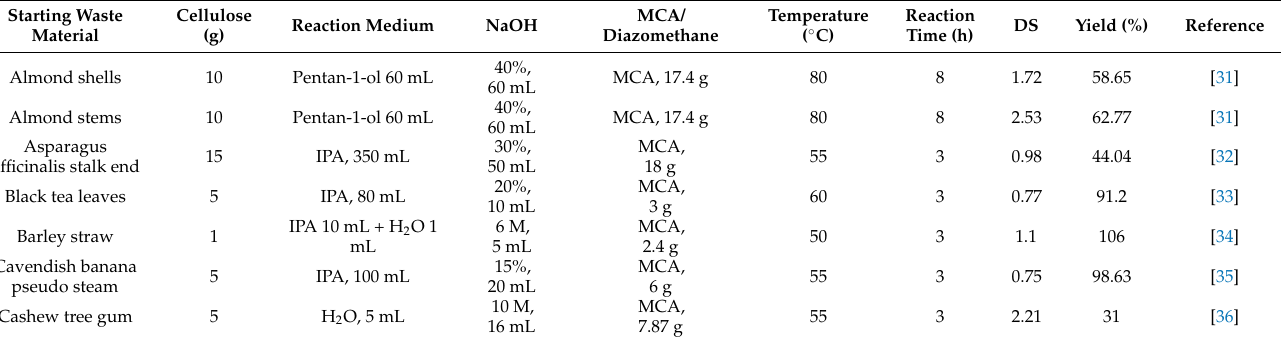
Table 1. Reaction conditions for carboxymethylation.